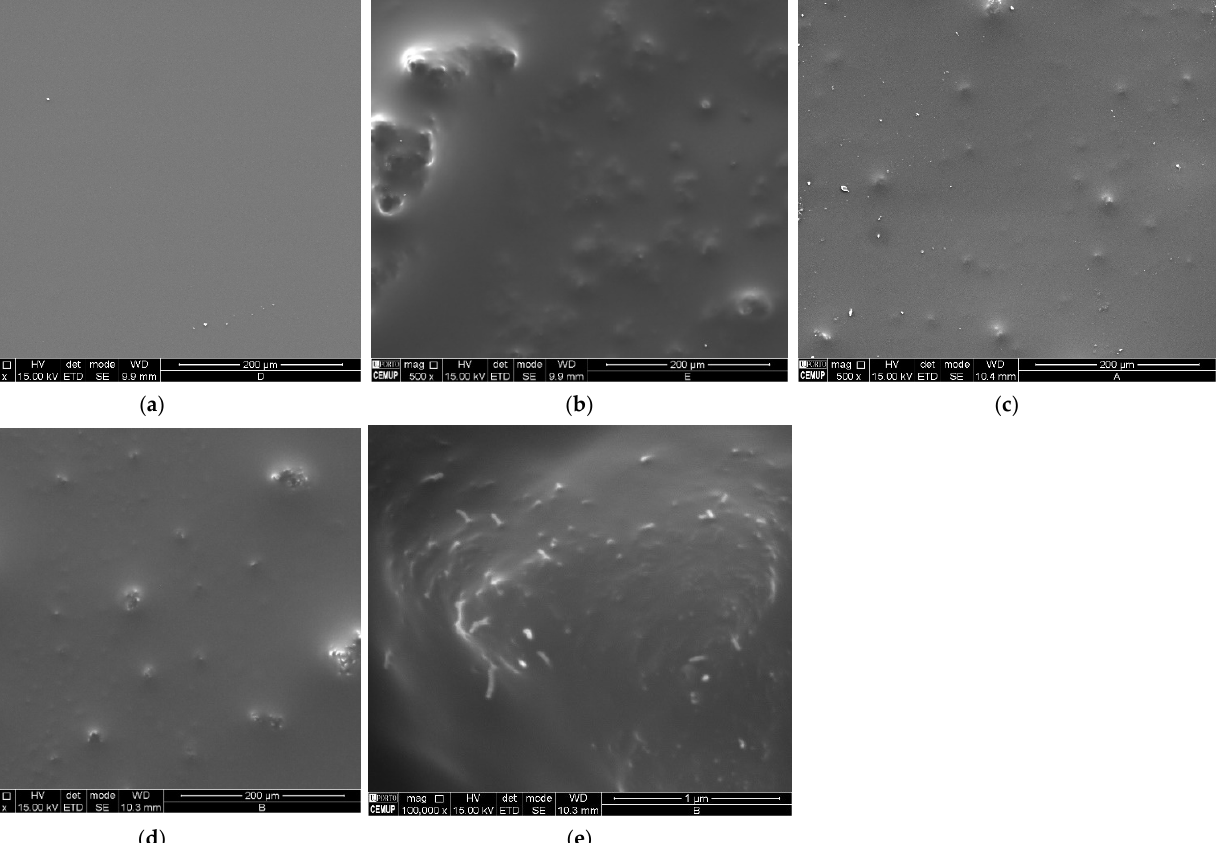
Figure 3. Scanning electron microscopy (SEM) images (magnification of 500 ×) of ( a ) poly(dimethylsiloxane) (PDMS); ( b ) 3 wt% CNT-O/PDMS; ( c ) 3 wt% CNT-BM 3 h/PDMS; and ( d ) 3 wt% CNT-BM 4 h/PDMS; ( e ) SEM image of 3 wt% CNT-BM 4 h/PDMS with a magnification of 100,000×.